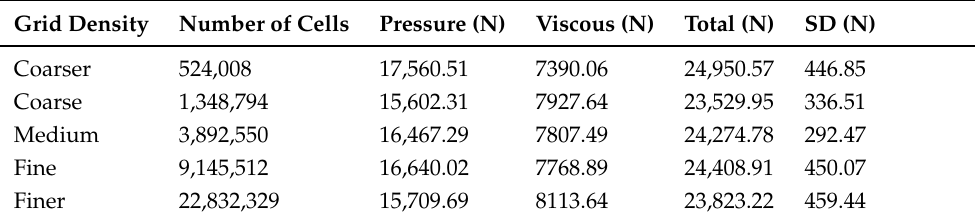
Table 10. Average and standard deviation of force components vs grid for submarine at condition 1 with Domain CFL = 4 and Free surface CFL =